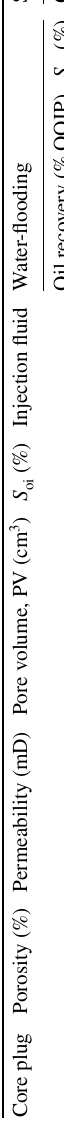
Fig. 15 Oil recovery profile of water injection and Vitagnus sur- factant flooding into the Asmari core plug: The blue line represents the brine injection into the core plug (secondary recovery), and the red line shows the recovery from the surfactant flooding (tertiary